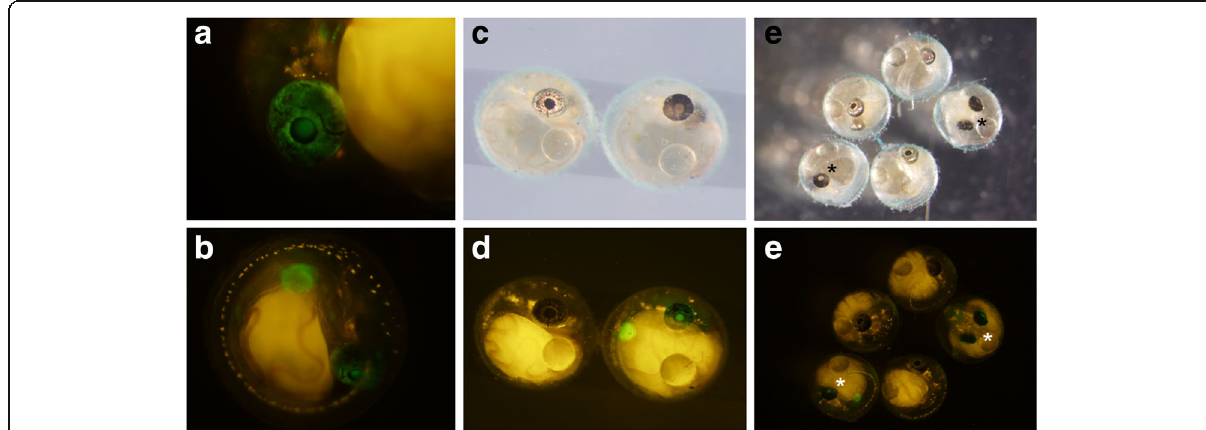
Fig. 6 Disruption of gene function by knocking-in pnp4a . ( a , b ) The expression pattern of GFP in founder fish. GFP expression was observed in the eye and abdomen. These fish were considered to have “ good expression ” of GFP, and were raised to adulthood. GFP expression was ob- served in the eye and abdomen. ( c – f ) The progenies (4 dpf) of a pnp4a-transgenic founder crossed to an existing gu mutant. All GFP-positive F1 fish have less-pigmented eyes and all GFP-negative F1 fish have wild-type pigmentation. Asterisks indicate GFP-positive and less-pigmented F1